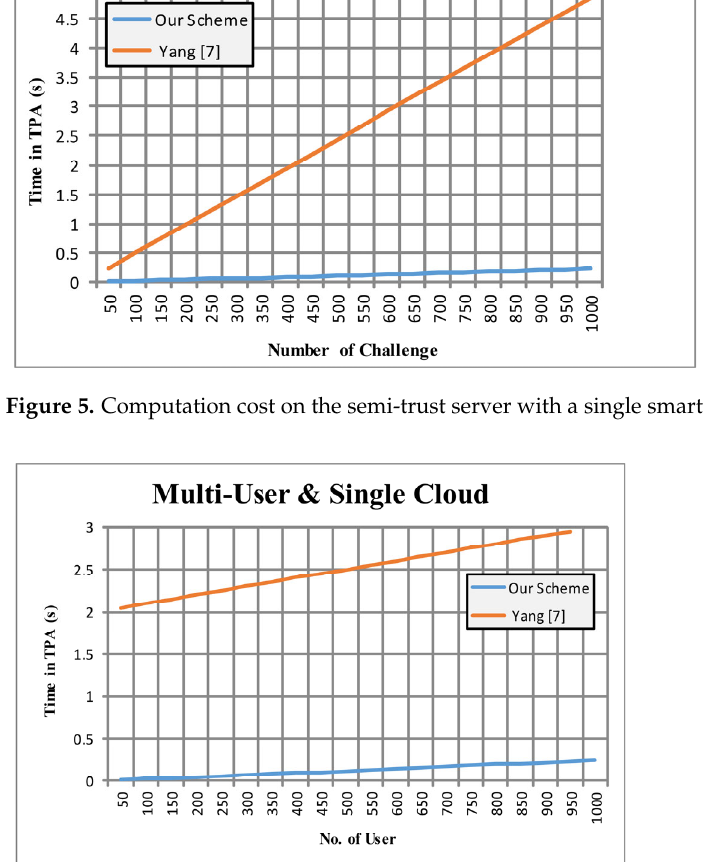
Figure 7. Computation cost for the IoT ‐ cloud system with a single smart device user and single cloud.